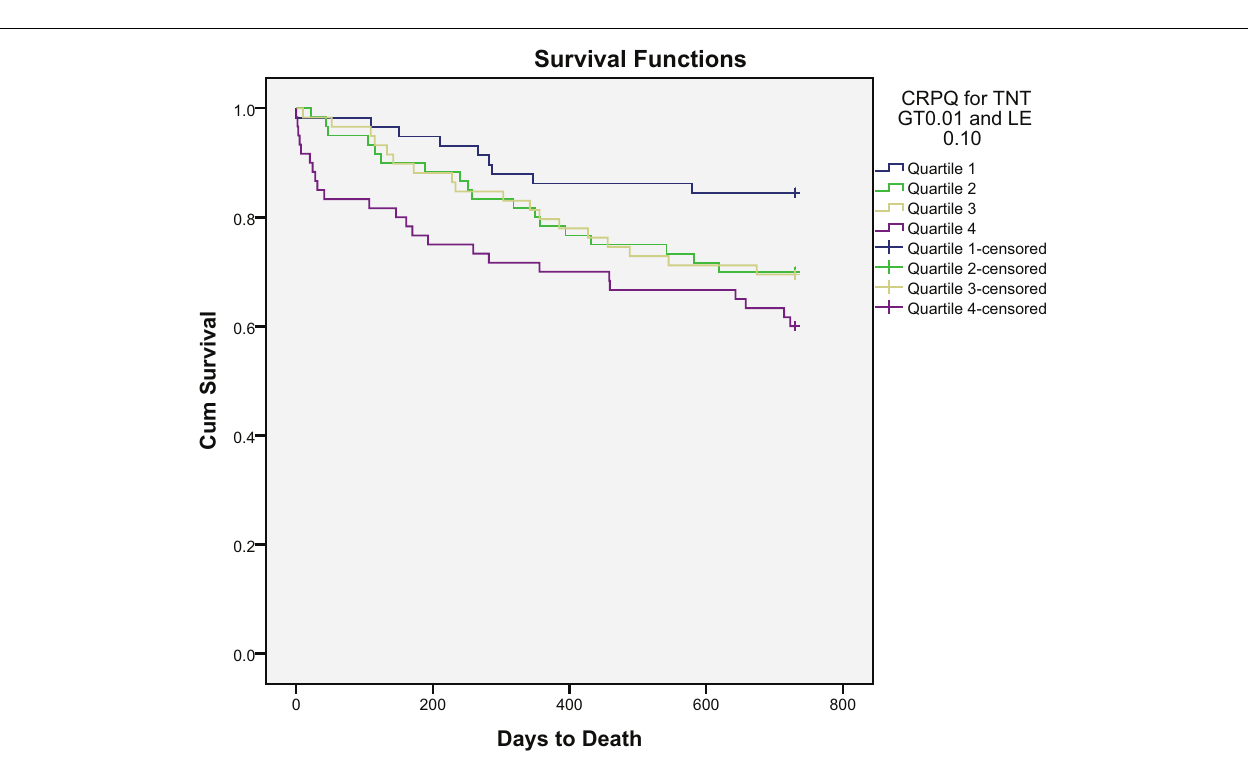
FIGURE 2 | Kaplan–Meier plot of time to all-cause mortality within 2years by hsCRP quartiles .